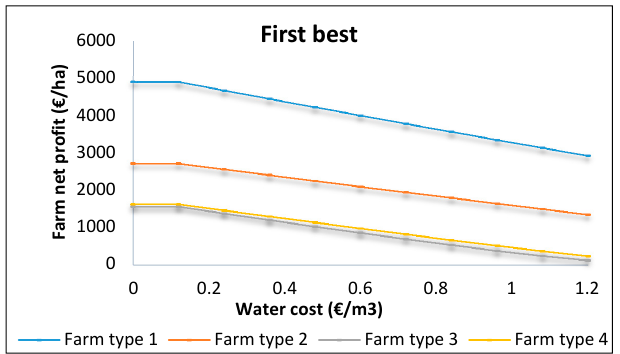
Figure 2. Farm net profit under flat rate water pricing scenario.